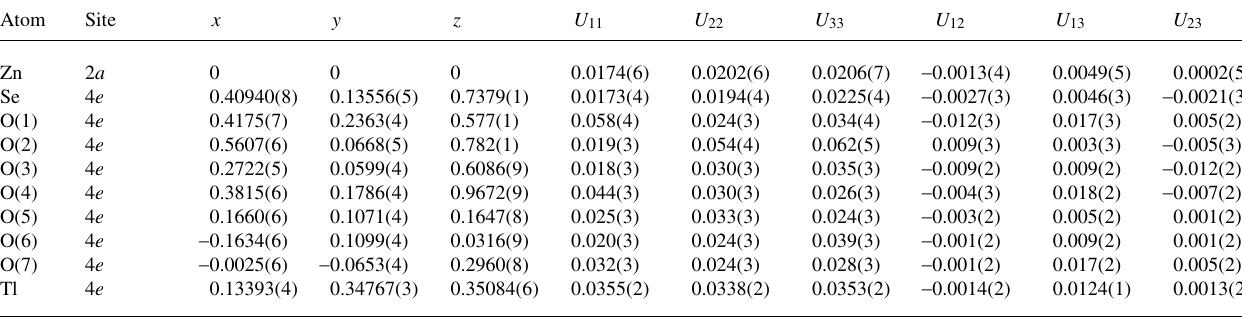
Table 18. Atomic coordinates and displacement parameters (in Å 2 ) .